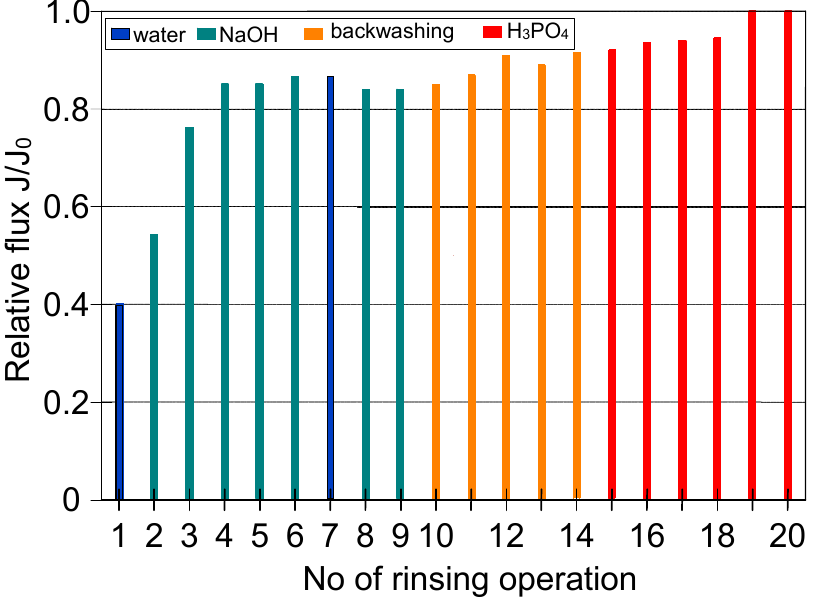
Figure 12. The efficiency of cleaning the ceramic membrane after the MF of 1,3-PD fermentation broth with Citrobacter freundii (V F = 5.5 m/s. TMP = 0.08 MPa). Operation time: water—30 minutes, NaOH—5 minutes, backwash—5 minutes, acid—10 minutes.